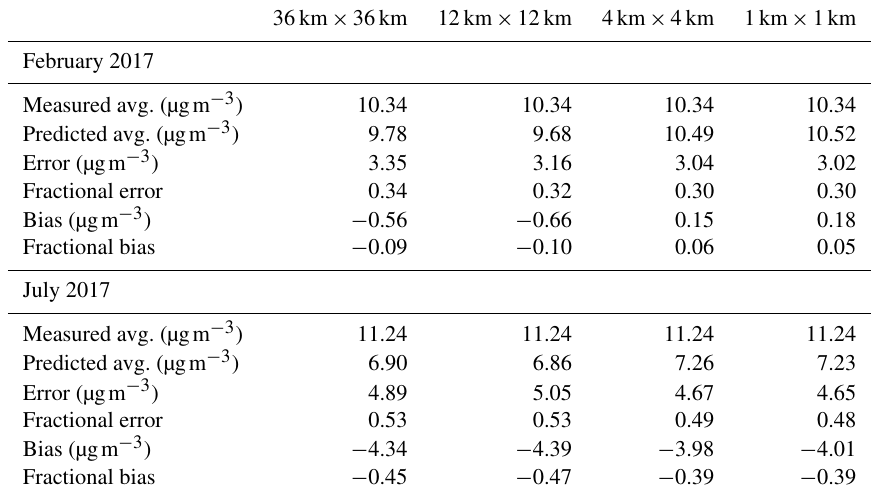
Table 2. Comparison of daily average PMCAMx-v2.0-predicted PM 2 . 5 concentrations during February and July 2017 with daily measure- ments from 17 EPA regulatory